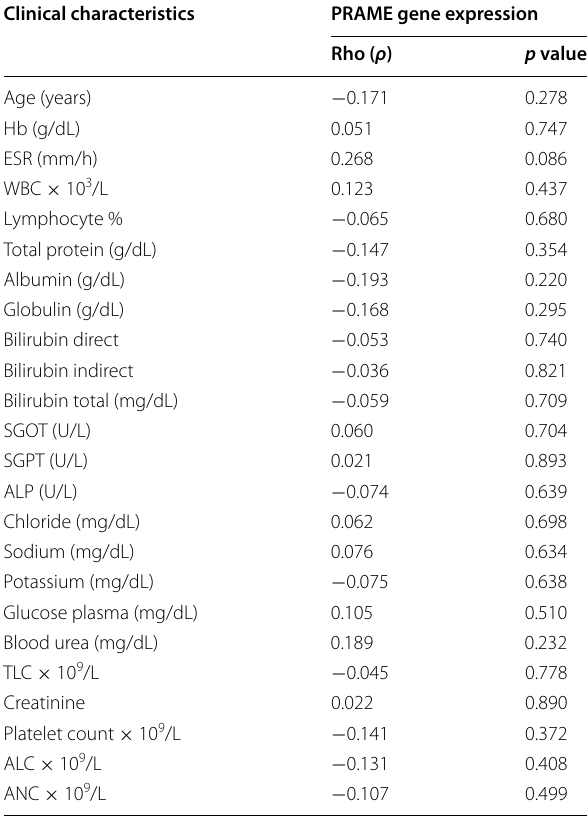
Table 4 Correlation of clinical parameters with PRAME gene expression in acute leukemia patients Clinical